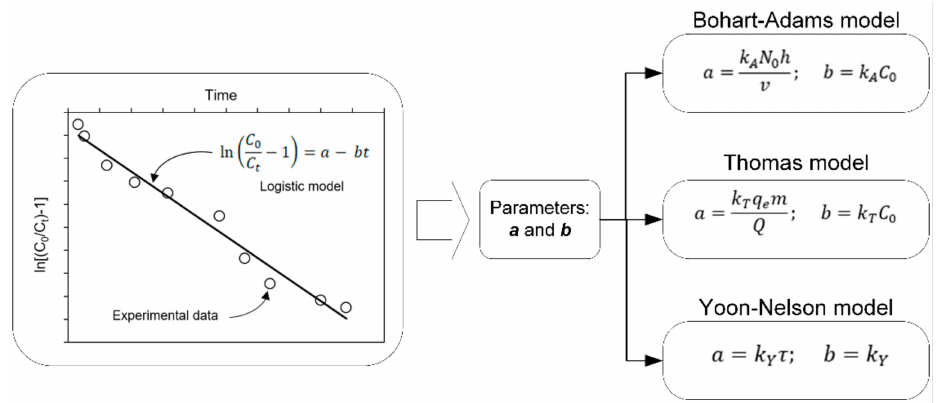
Figure 1. Correlations to estimate Bohart–Adams, Thomas, and Yoon–Nelson parameters. The authors state that the Thomas and Yoon–Nelson models are equivalent in terms of mathematical form, but despite that, they compare these two models and conclude that the Thomas model could best describe the column adsorption behavior. With the Logistic model, there is a single correlation coefficient value (R 2 ), so it is not possible to compare and say that one is better than the other since all three are mathematically equivalent. In and their conclusions are not